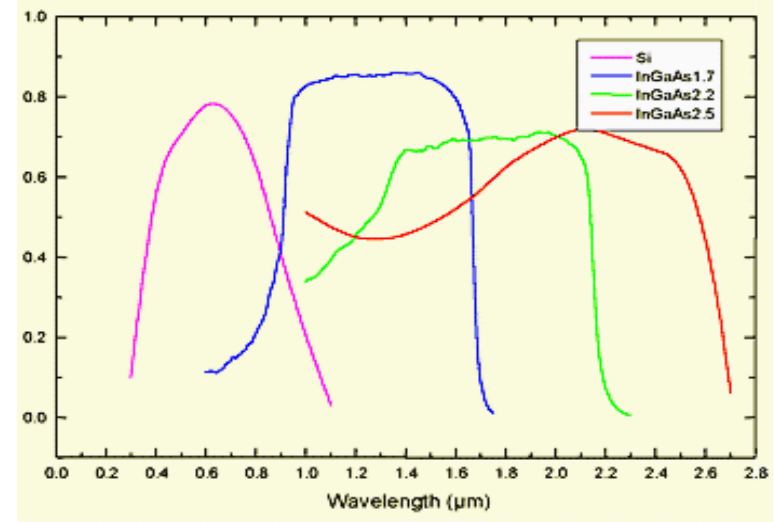
Figure 4. QE comparison of InGaAs detectors and Si-based